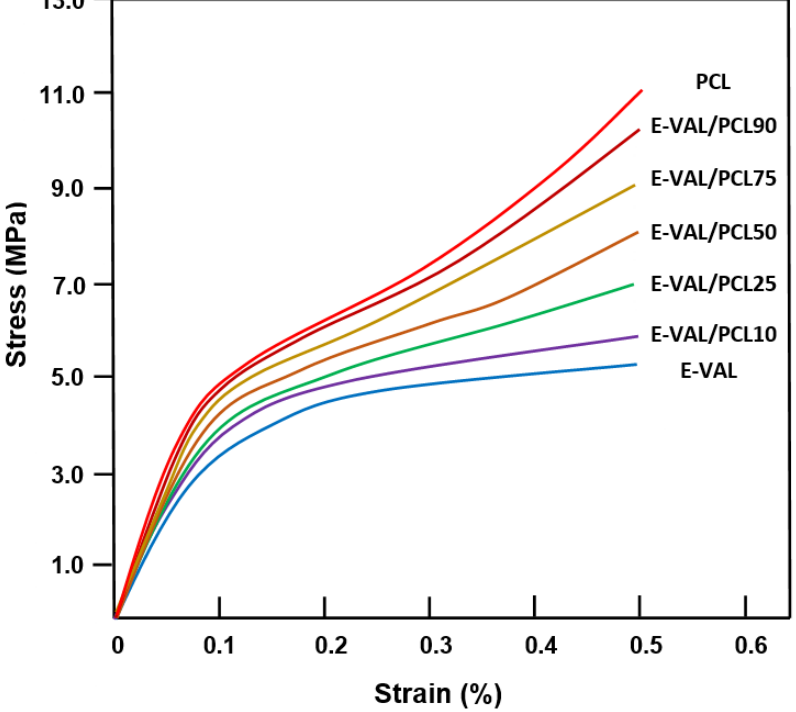
Figure 7. Stress–strain curves of wet PCL, E-VAL and E-VAL/PCL scaffolds with different E-VAL